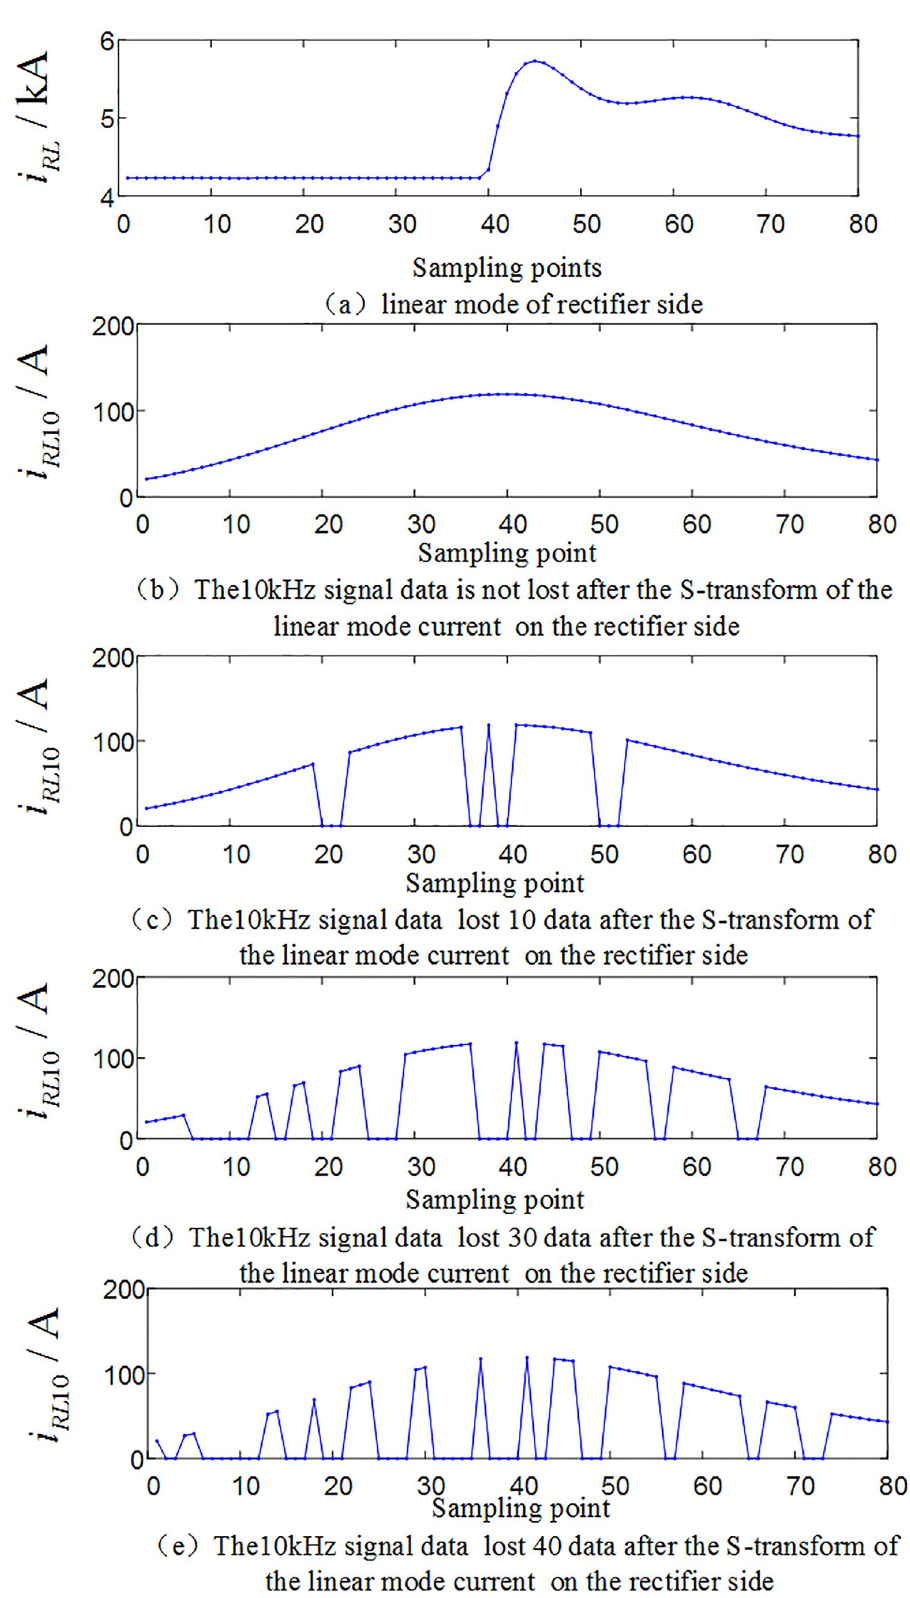
Fig 19. Correlation waveforms of data loss (10~40 data) randomly.